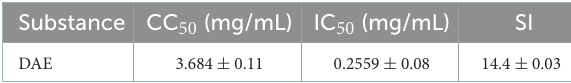
TABLE 2 The CC 50 , IC 50 , and SI of the